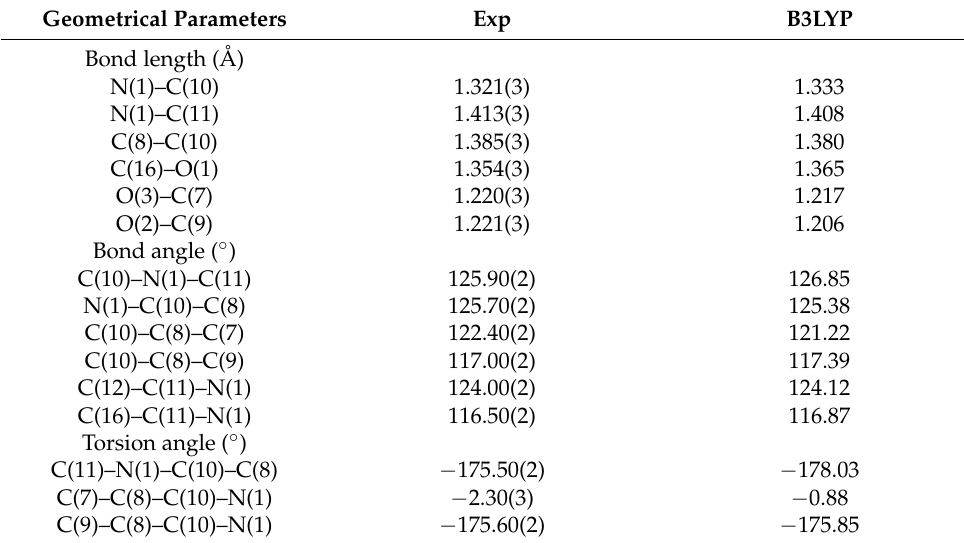
Table 3. The hydrogen bonds for HMD.